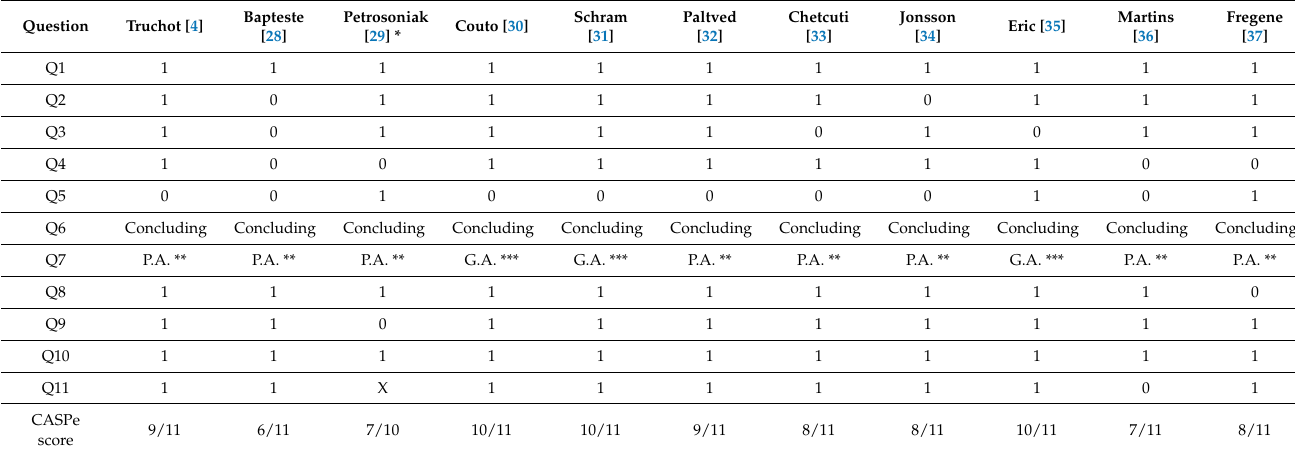
Table 3. Quality criteria according to the CASPe